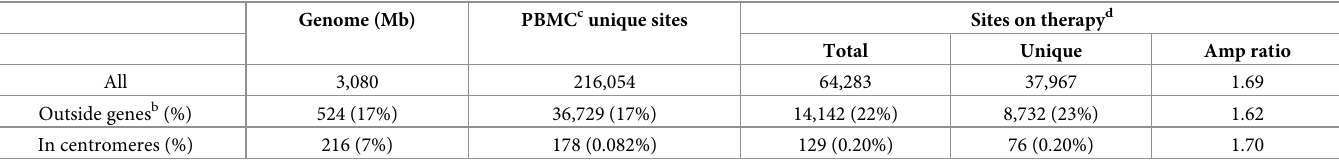
Table 4. IS detected in centromeric repeat DNA a